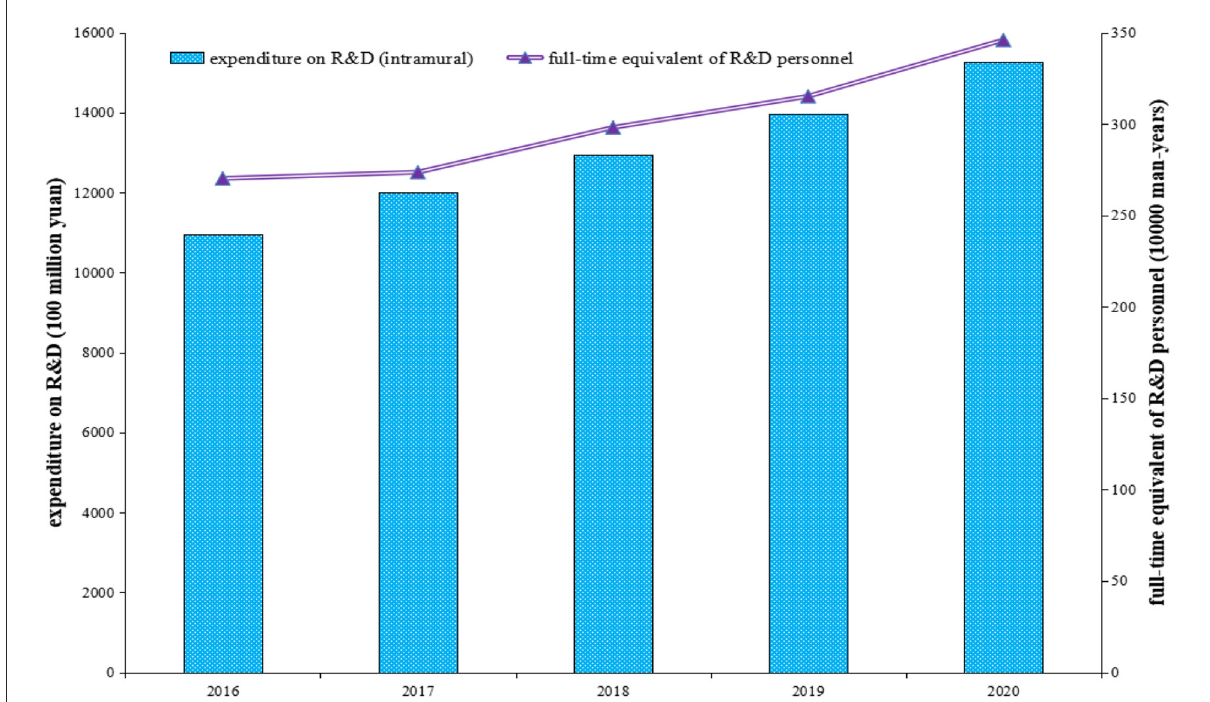
FIGURE4 Research and development (RandD) activities in the industrial sector in China during 2016–2020. Source: The author obtained the information from the China Statistical Yearbook on Science and Technology